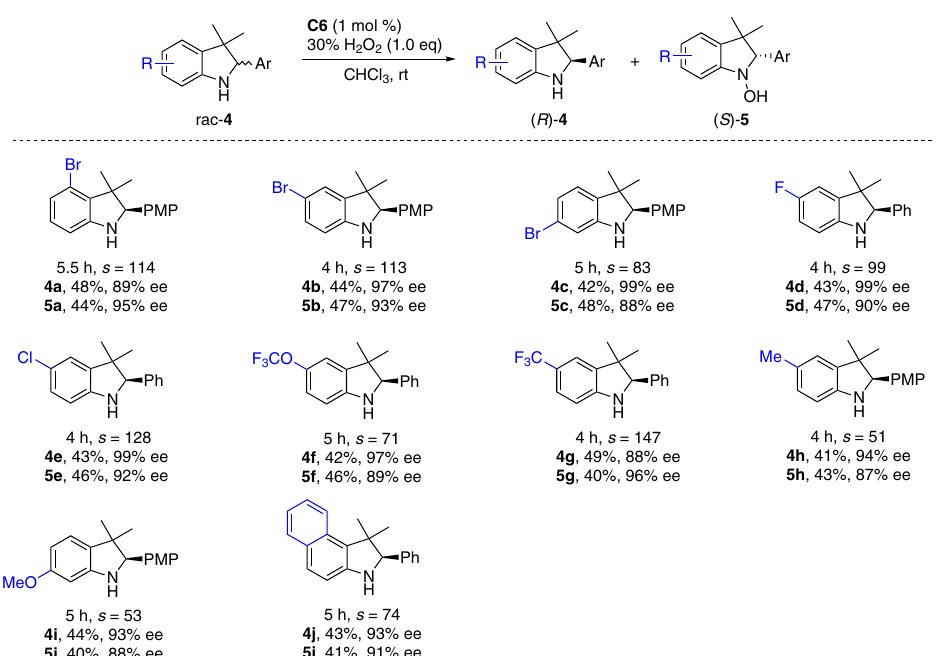
Fig. 3 Substituent effects on the indoline arene. Conditions: rac- 4 (0.1 mmol), 30% aqueous H 2 O 2 (0.1 mmol), and C6 (1 mol %) in CHCl 3 (1.0 mL) at rt for indicated time period.